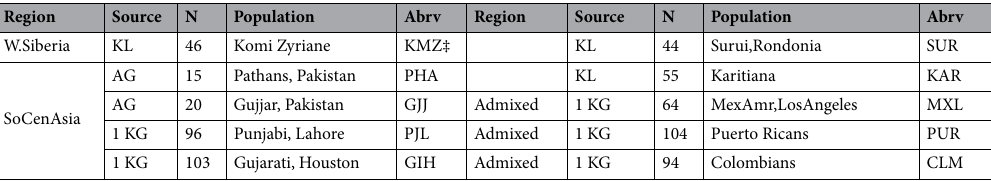
Table 2. The list of populations and sample sizes ordered by broad geographic regions. ‡ = Indicates 15 populations in analyses of North Asia along with outlier groups from nearby regions of the world. Source